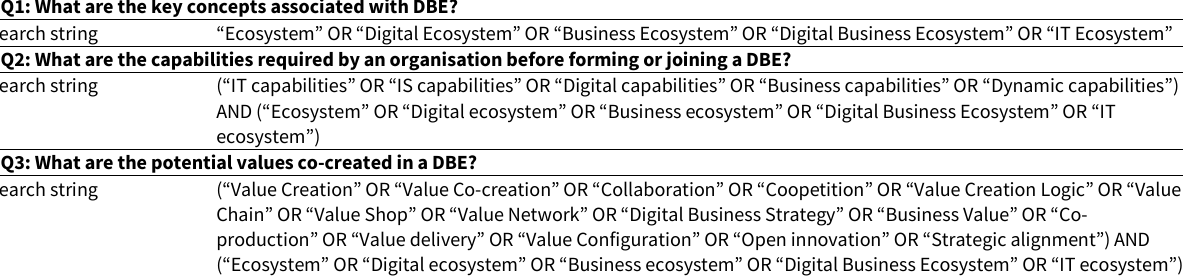
Table 1. Search strings of this review study